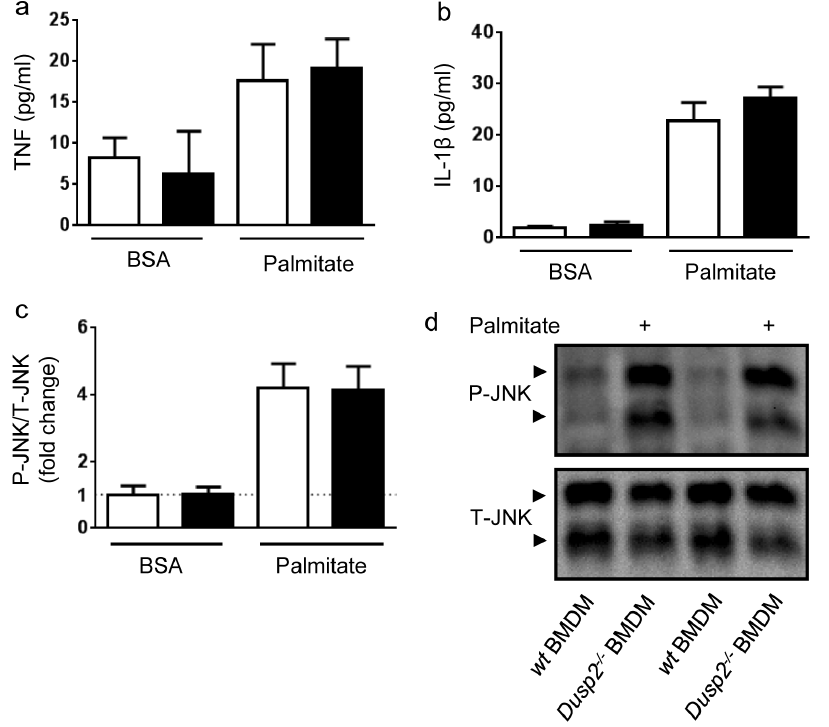
Figure 7. Treatment of BMDM from wt and dusp2 2 / 2 mice with the free fatty acid palmitate. BMDM were treated for 8 h ( a and b ) or 4 h ( c and d ) with either a control stimulus (BSA; white bars) or 1 mM Palmitate (black bars). d shows representative western blots from the quantifications shown in c . Data represent 3 separate mice per genotype each performed with 3 technical replicates. Data are mean 6 SD.